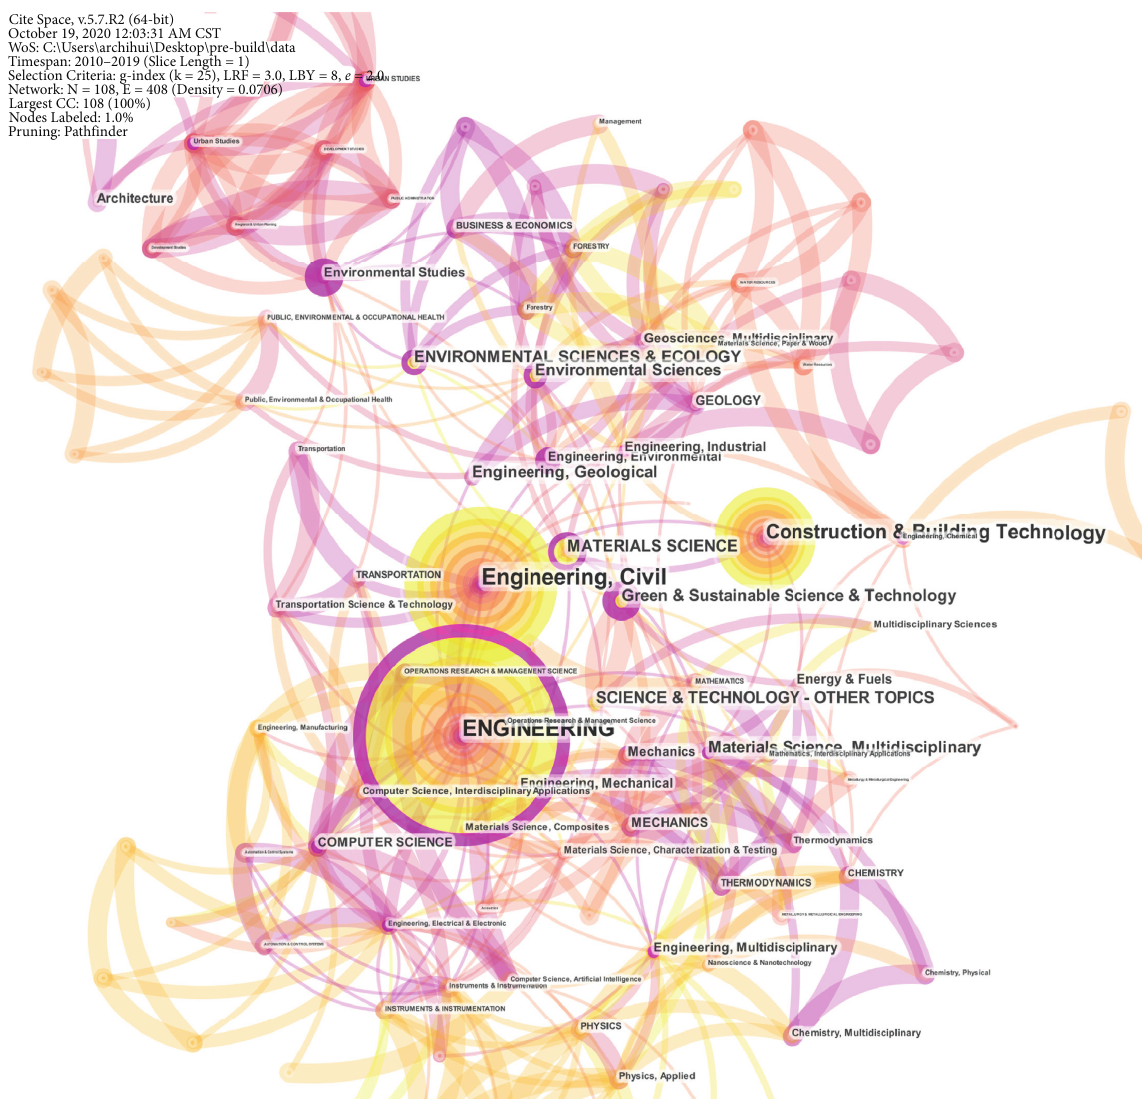
Figure 4: Co-occurring network of subject